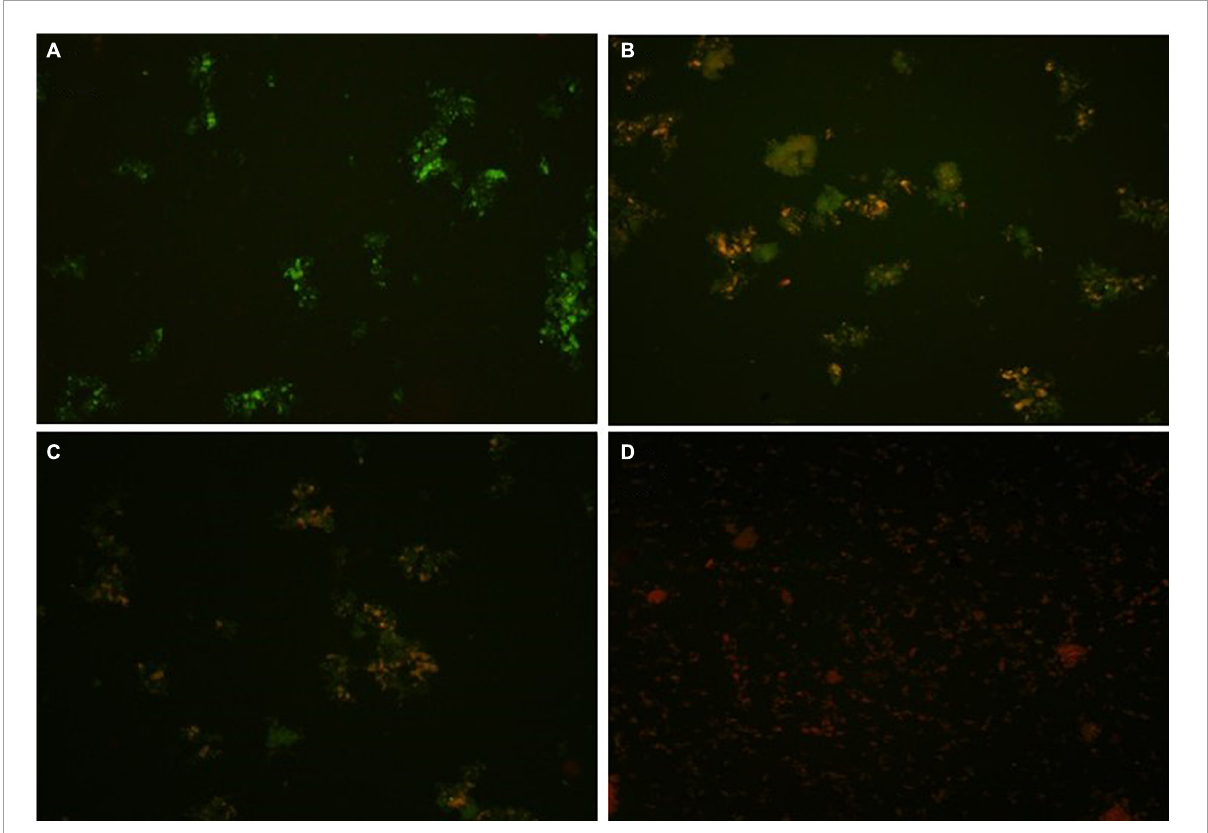
FIGURE3 Confocal laser scanning microscopy (CLSM) based membrane permeability analysis of isolate ANCB-12 under different CBZM concentrations. (A) Untreated cell, (B) 1,000 µ g/ml CBZM treated cell, (C) 2,000 µ g/ml CBZM treated cell, and (D) 3,000 µ g/ml CBZM treated cell.